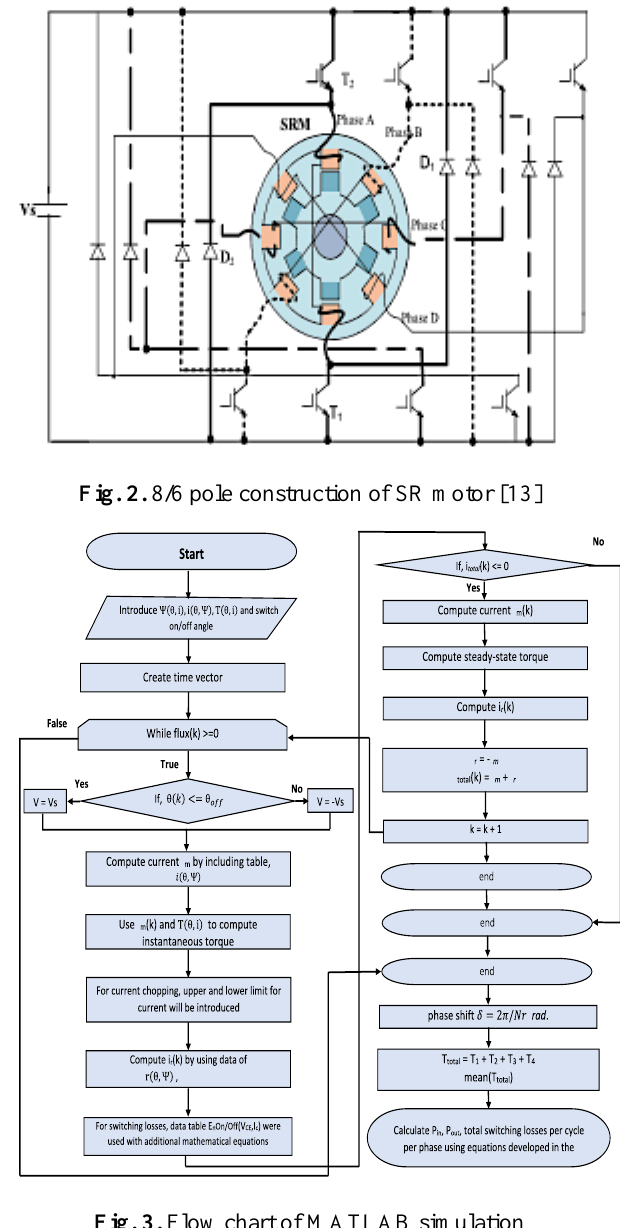
Fig. 3. Flow chart of MATLAB simulation